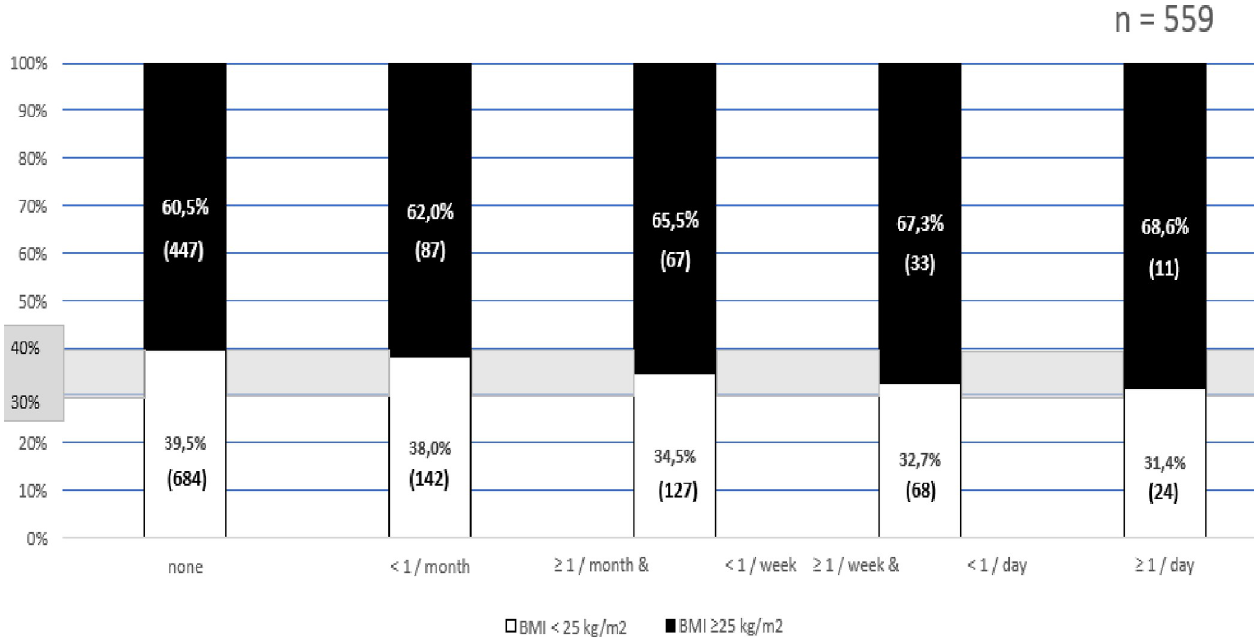
Fig 3. The frequency of GERD-related typical symptoms is positively associated to the presence of overweight (R 2 = 0.63, P = 0.0497). Similar association was found if all (typical + atypical) reflux related symptoms were